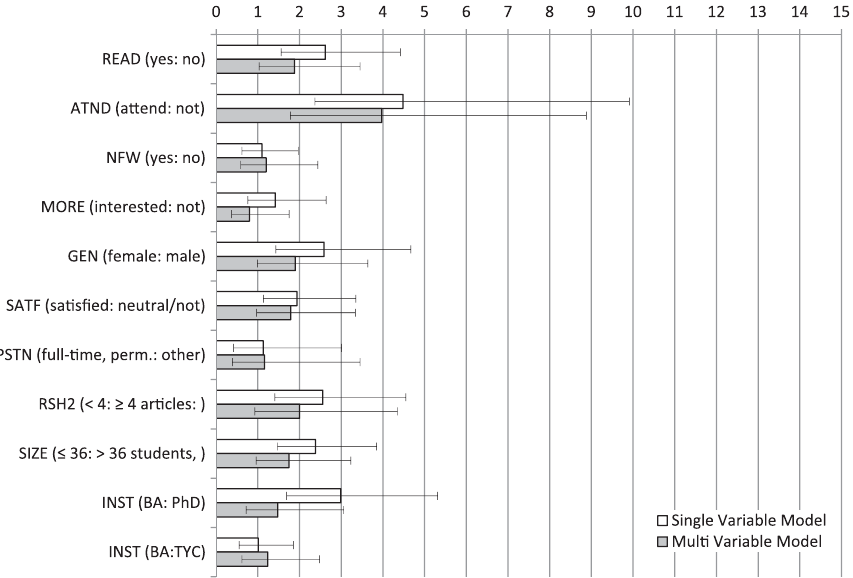
FIG. 5. Odds ratios and 95% confidence intervals for high versus low user groups. A confidence interval that includes ‘‘1’’ suggests that the groups are not significantly